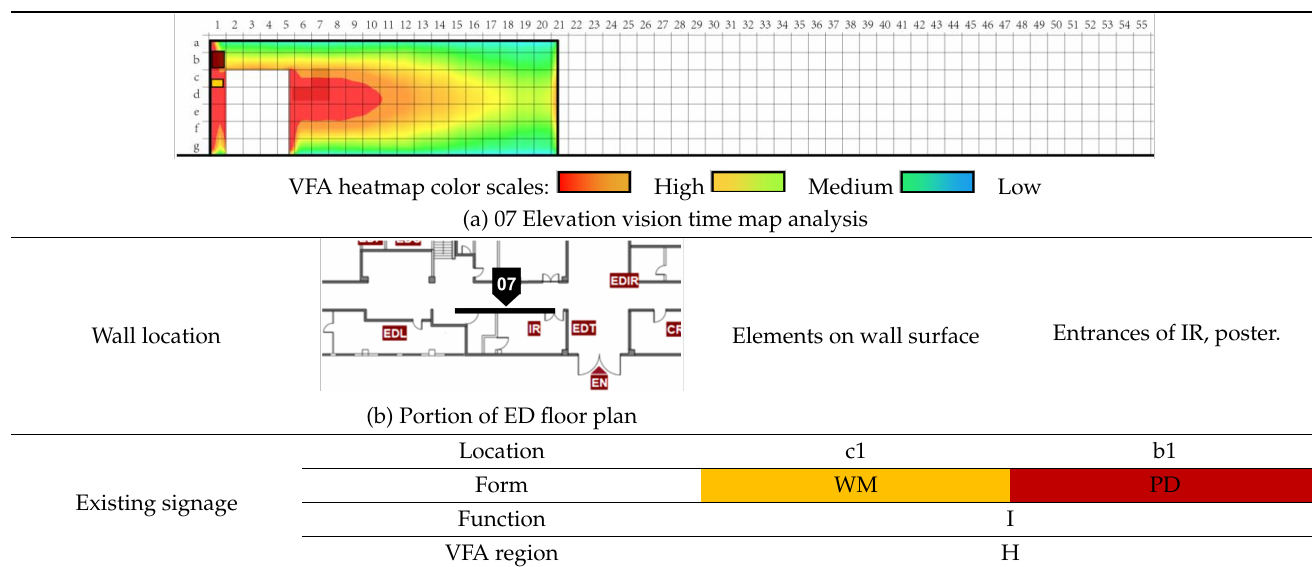
Table 11. 07 Elevation comparative